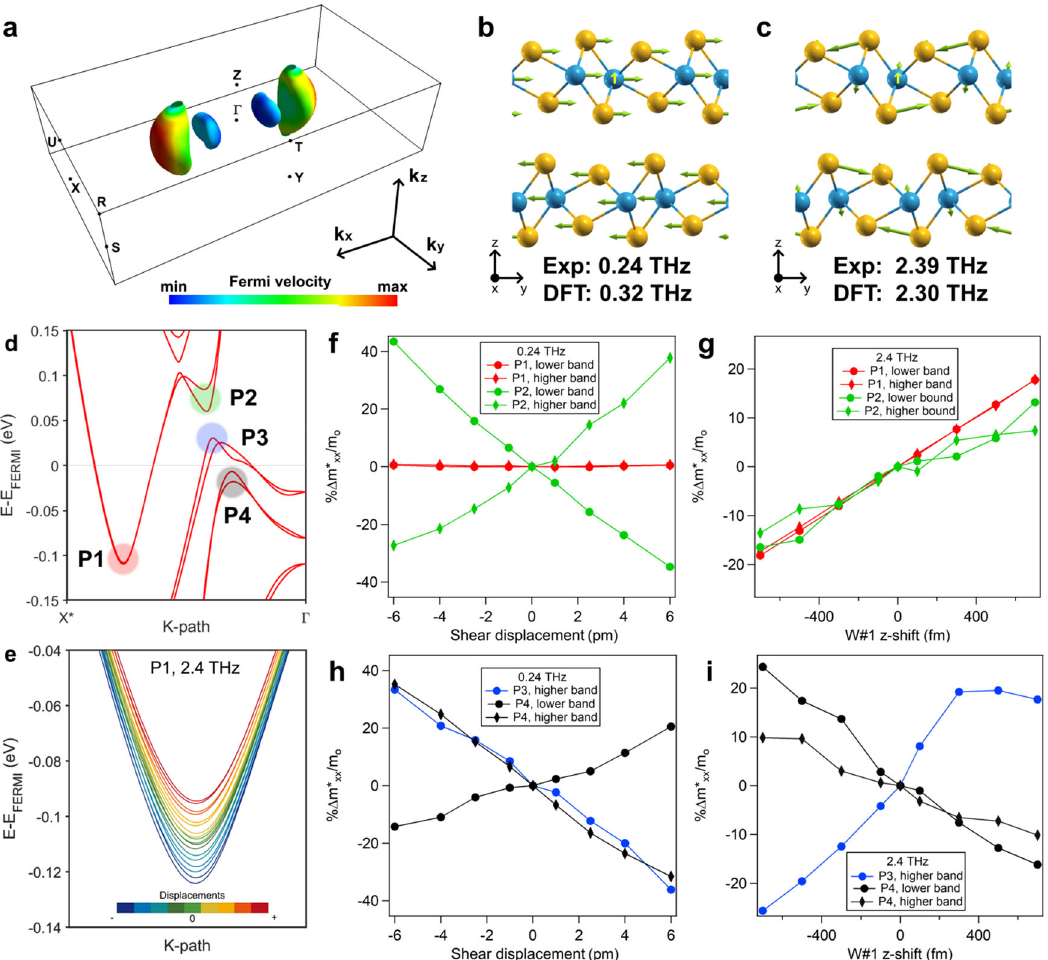
Fig. 5 DFT simulation results. a Fermi surface of WTe 2 plotted using FermiSurfer 57 . The color scale indicates the modulus of the Fermi velocity. Coherent optical phonons at b ≈ 0.24 THz (shear mode) and c ≈ 2.4 THz as derived from DFPT and plotted using XCrySDen 58 . d Band dispersion along X* (0.3 0 0) – Γ (0 0 0) around the Fermi level. Selected interesting regions are highlighted for the following analysis. e Example of band structures modi fi cations at P1 due to the phononic displacements (from – 700 to 700 fm with the steps shown in panel g , i . f – i Effective mass changes around P1 (0.228 0 0), P2 (0.123 0 0), P3 (0.117 0 0), and P4 (0.093 0 0); these coordinates are expressed in reciprocal lattice units. W#1 refers to the labeling for the unit cell atoms reported in Fig.